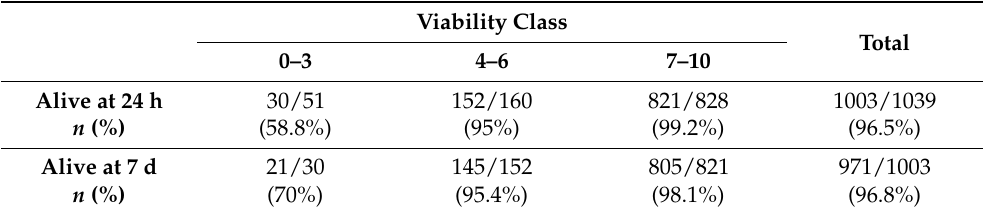
Table 7. Distribution (expressed as number and %) of newborn survival at 24 h and at 7 days (d) of age according to viability classification.